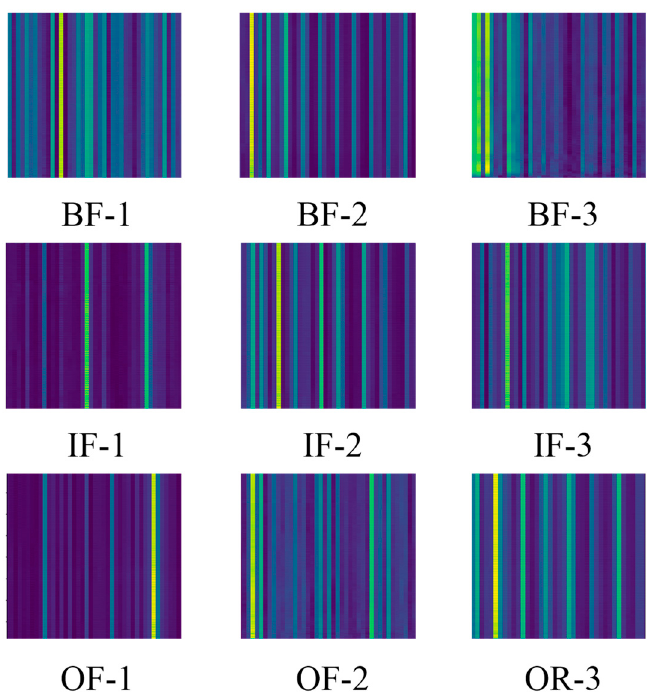
Figure 7. Converted images on nine fault